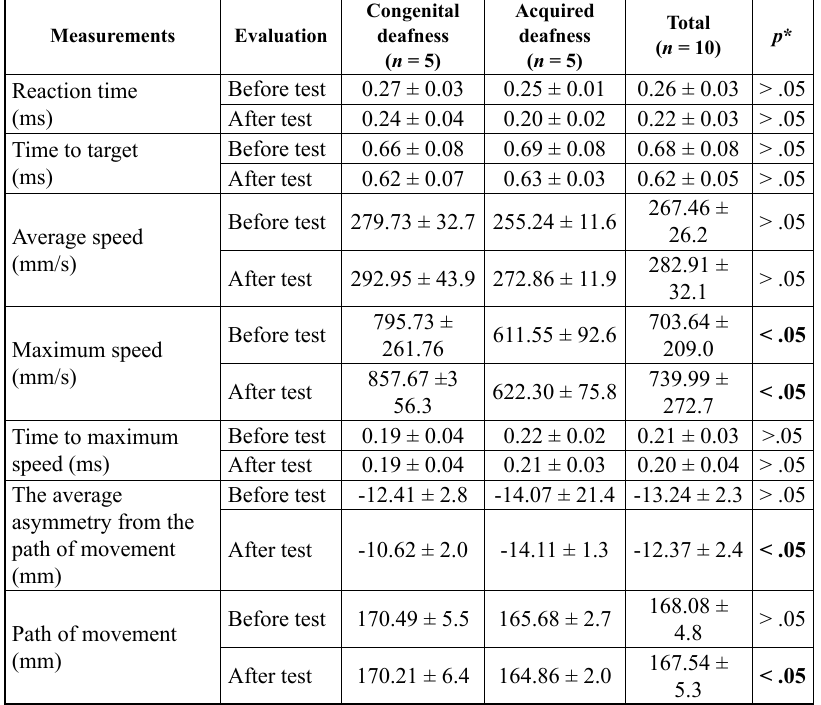
Table 1. DPA – 1 measurements depending on the nature of deafness